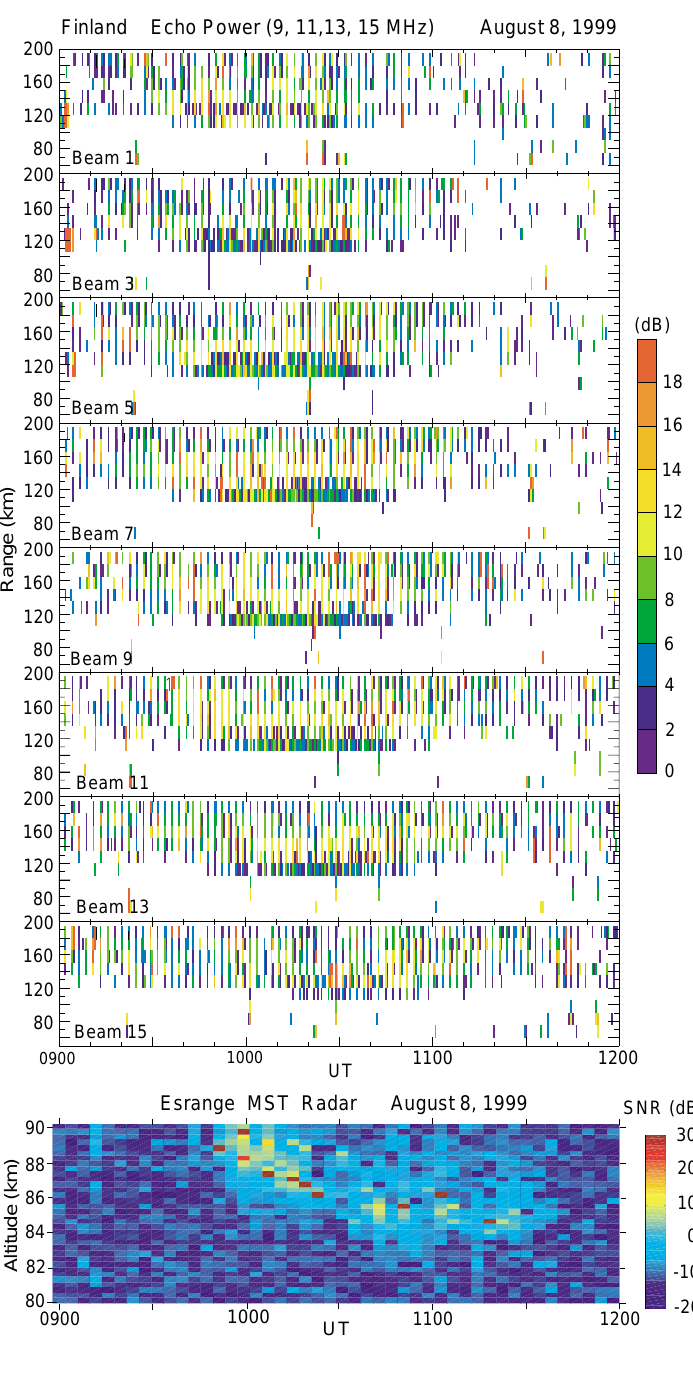
Fig. 2. (Upper) Time and slant range distributions of echo power observed at four frequencies on eight beams (beams 1, 3, ..., 15) of the Finland HF radar, and (lower) time and altitude distribution of echo power observed with the ESRAD radar between 09:00 and 12:00UT on 8 August